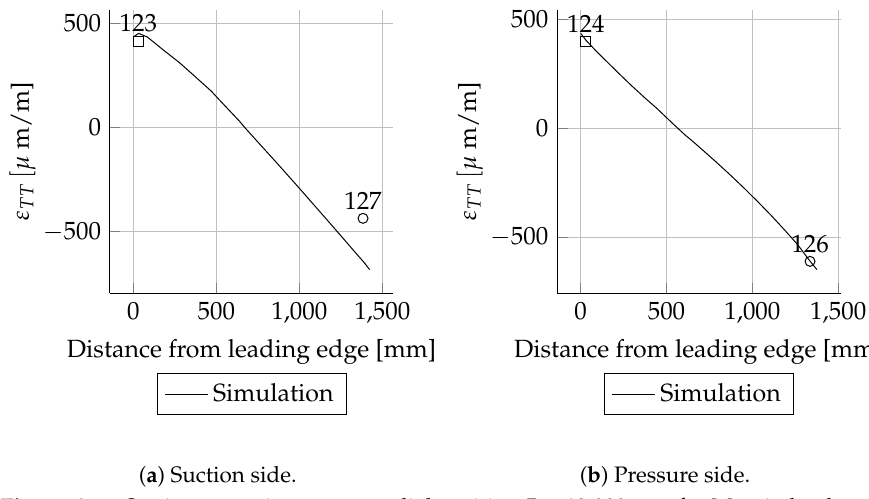
Figure A23. Strain comparison ε LL at radial position R = 13,000 mm for Mxmin load